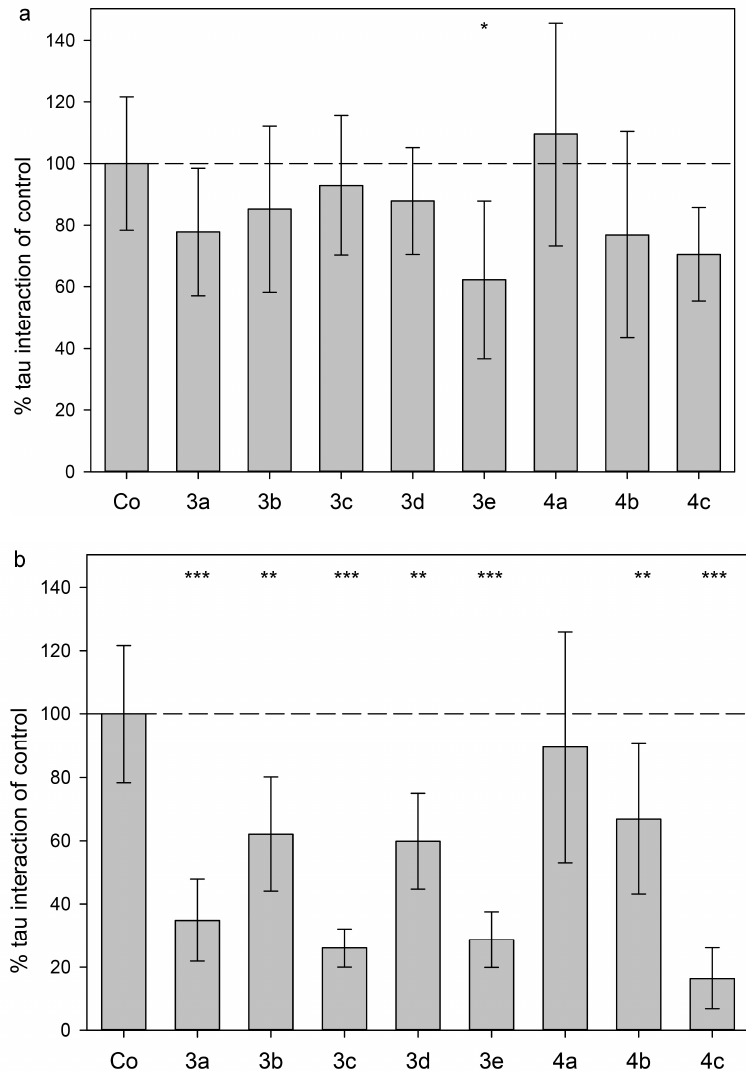
Figure 2. Modulation of tau interaction by protein kinase inhibitors. Tau protein self-interaction was assessed using a split-luciferase assay. Luminescence readings were related to vehicle control (Co) and normalized to the full length constitutively-active NanoLuc luciferase and depicted as mean ± SD. ( a ) Inhibitor concentration of 1 µM and ( b ) inhibitor concentration of 10 µM. * p < 0.05; ** p < 0.01, *** p < 0.001.